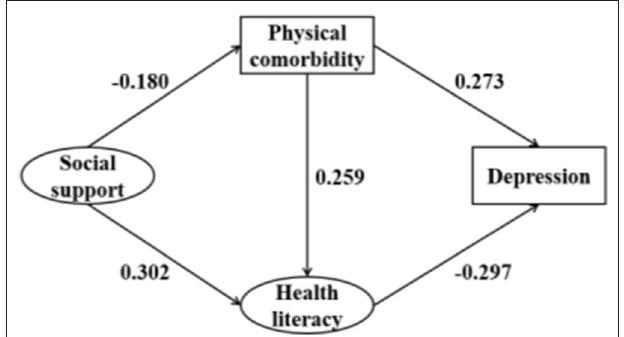
TABLE 4 | Multiple linear regression analysis of factors associated with depression.